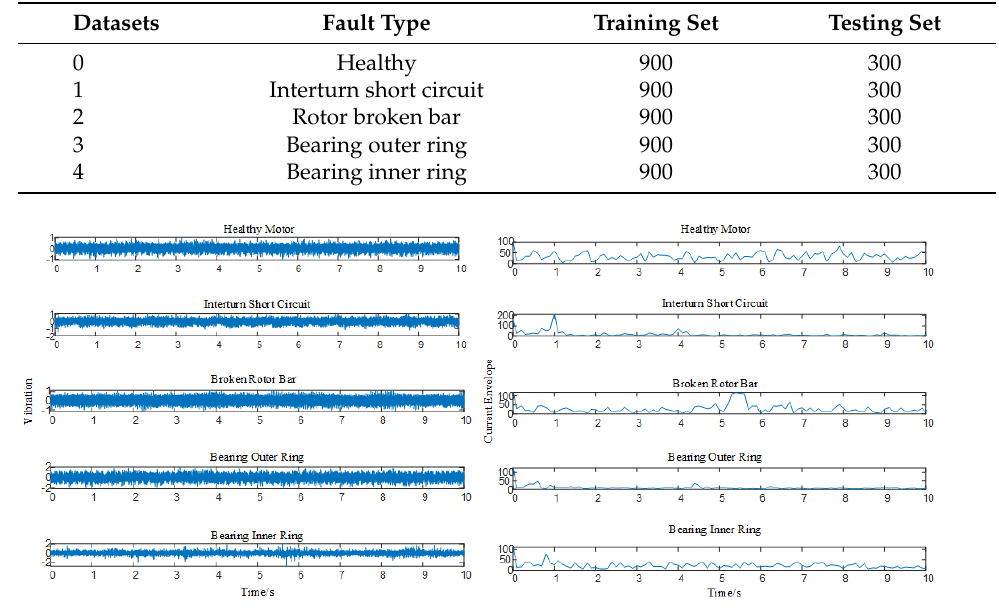
Figure 9. No load motor